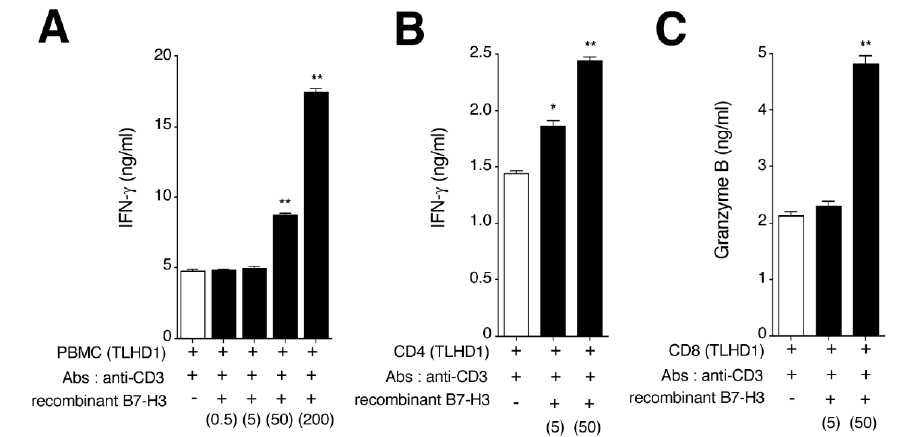
Figure 7. Capacity of human iPS-RPE cells to stimulate the activation of bystander T cells via B7-H3. Recombinant human B7-H3 proteins were used in in vitro assays with lymphocytes. ( A ) PBMC were cocultured with recombinant B7-H3 (0.5. 5, 50, or 200 ng/mL) in the presence of antihuman CD3 antibody for 72 h. The supernatants were harvested for IFN- γ ELISA. ( B ) Purified CD4 + T cells were cocultured with recombinant B7-H3 (5 or 50 ng/mL) and evaluated by IFN- γ ELISA. ( C ) Purified CD8 + T cells were cocultured with recombinant B7-H3 (5 or 50 ng/mL) and evaluated by granzyme B ELISA. Data are the means ± SEM of 3 ELISA determinations. * p < 0.05, ** p < 0.005, as compared to positive controls (open bar: no recombinant B7-H3). Data are representative of 3 individual experiments. ( D ) CD4 + T cells were cocultured with iPS-RPE cells (454E2) in the presence of antibodies such as anti-B7- H3, anti-B7-H1, or isotype control (mouse IgG) and assessed by IFN- γ ELISA (T cell:RPE ratio = 100:1). ( E ) CD4 + T cells were also cocultured with iPS-RPE cells in the presence of anti-CD3 (1 st signal blocking) plus anti-B7-H3 (2 nd signal blocking) and assessed by IFN- γ ELISA (T cell:RPE ratio = 100:1). Data are the means ± SEM of 3 ELISA determinations. ** p < 0.005, *** p < 0.0005, as compared to 2 groups. n.s., not significant. As a final step, we examined whether downregulation of B7-H3 on iPS-RPE cells could stimulate uveitis T cells in vitro. Compared with control-siRNA-transfected iPS-RPE cells, the expression of B7- H3 mRNA in B7-H3-siRNA-transfected RPE cells was strongly downregulated according to FACS (Figure 8A) and qRT-PCR (Figure 8B). In in vitro assays, B7-H3-siRNA-transfected iPS-RPE cells failed to stimulate uveitis T cells, while control-siRNA RPE cells actually activated uveitis T cells in